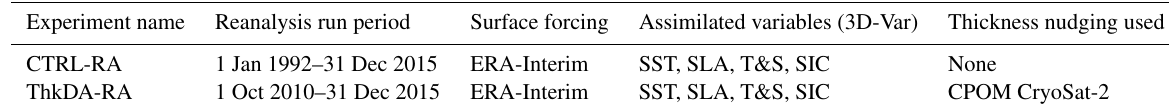
Table 1. Details of ocean–sea ice reanalysis experiments used in this study.